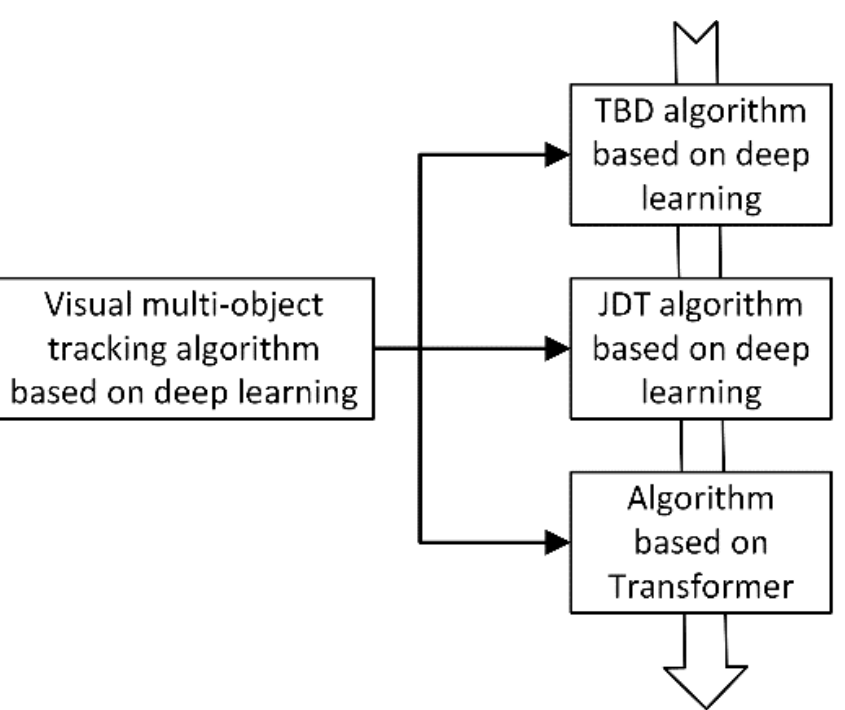
Figure 3. Classification and algorithm of visual multi-object tracking based on deep learning. Overall, the development trend of visual multi-object tracking algorithm is from TBD, to JDT, to Transformer-based tracking algorithm.